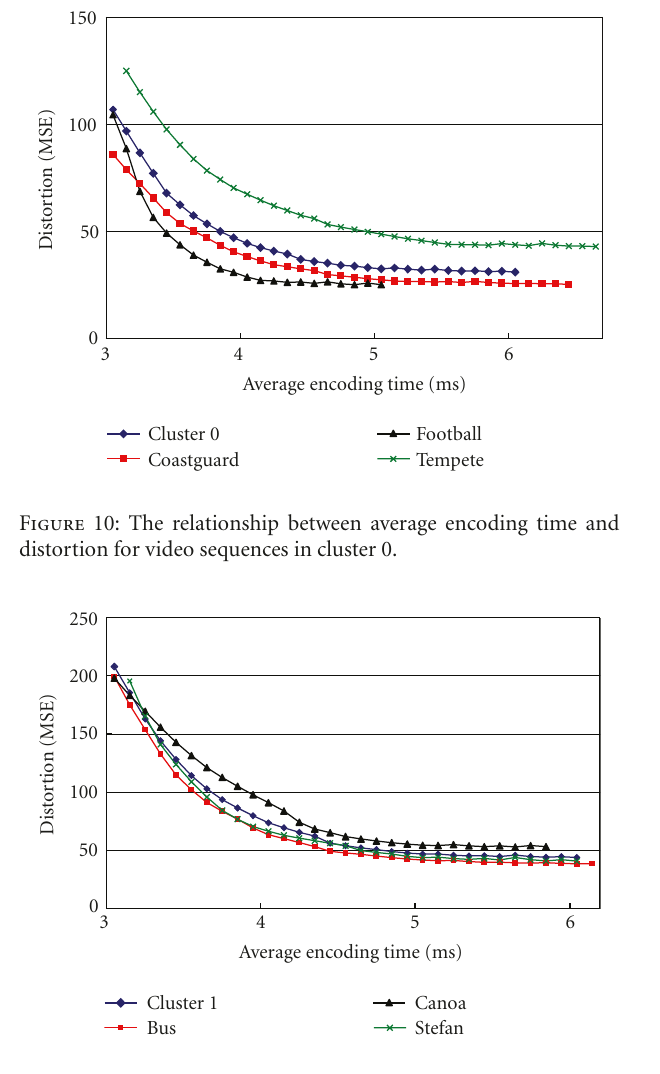
Figure 11: The relationship between average encoding time and distortion for video sequences in cluster 1. Table 3: Average execution time to solve a linear programming problem.